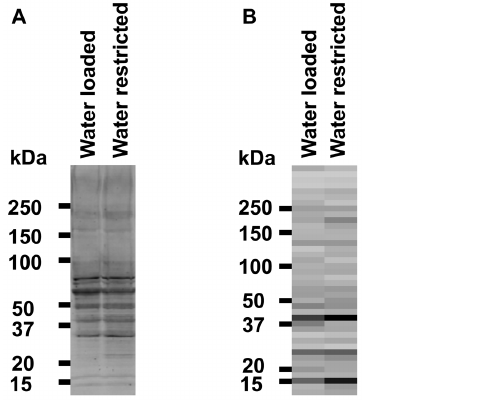
Figure 7. Effects of water balance changes on carbamylation. A. Immunoblot of Water Loaded rat vs. Water Restricted rat using anti- carbamyl-lysine antibody. Animals were water restricted (17 ml of water/day) or water loaded (40 ml of water/day) for five days. B. Heat map representation of mass spectrometry data provides a pseudo immunoblot of total carbamylated proteins. Animal treatments were